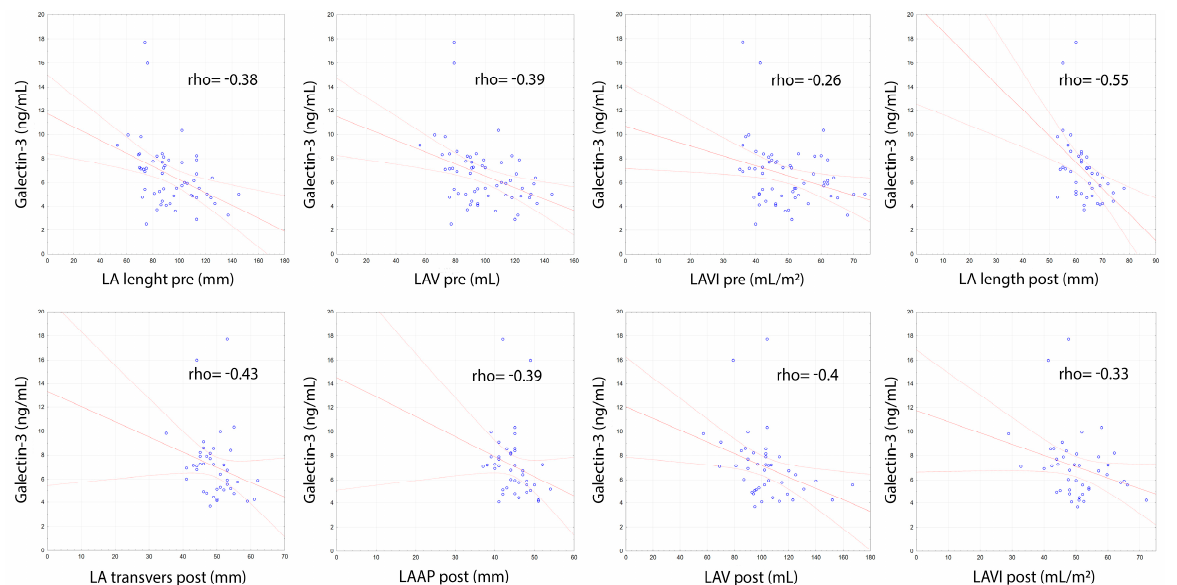
Figure 1. Correlations of galectin-3 concentration with echocardiographic measurements of left atrial dimensions and volume assessed before and after electrical